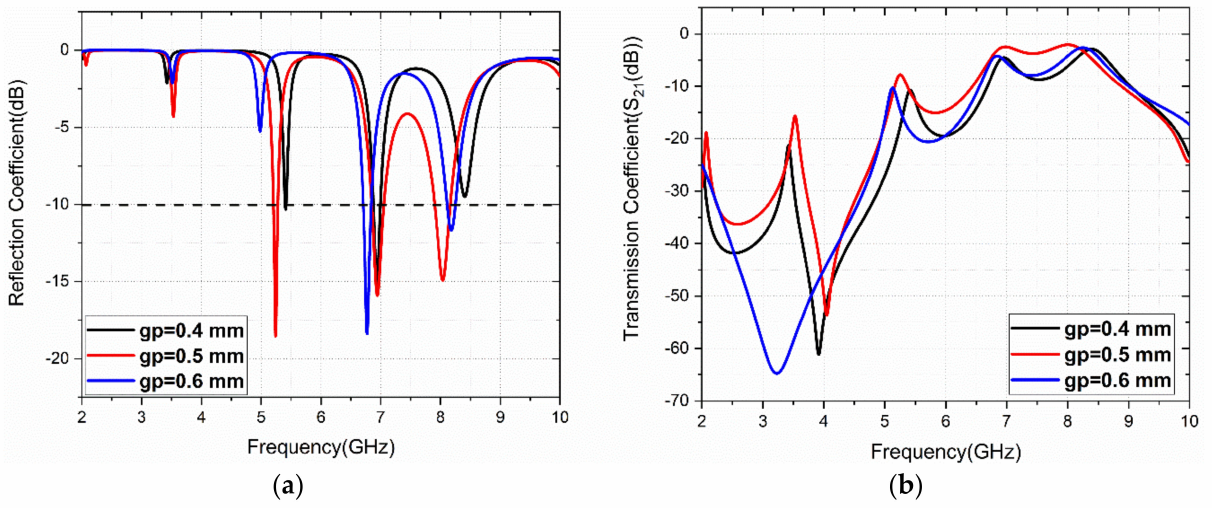
Figure 4. Parametric analysis of gap (gp) between S-and G-patches: ( a ) S 11 (dB), ( b ) S 21 (dB).